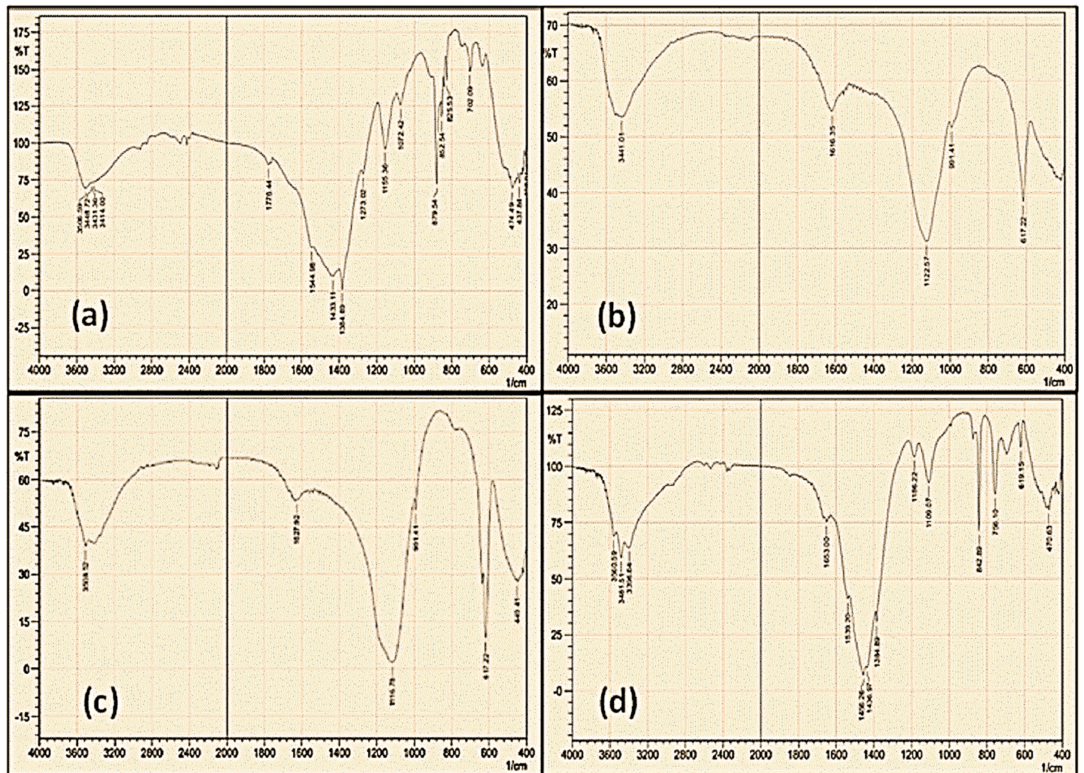
Figure 10. The FTIR spectra of ZnO nanoparticles synthesized by using a green method and the leaf extract of the thyme plant at different calcination temperatures: ( a ) 150 ◦ C, ( b ) 250 ◦ C, ( c ) 350 ◦ C, and ( d ) 450 ◦